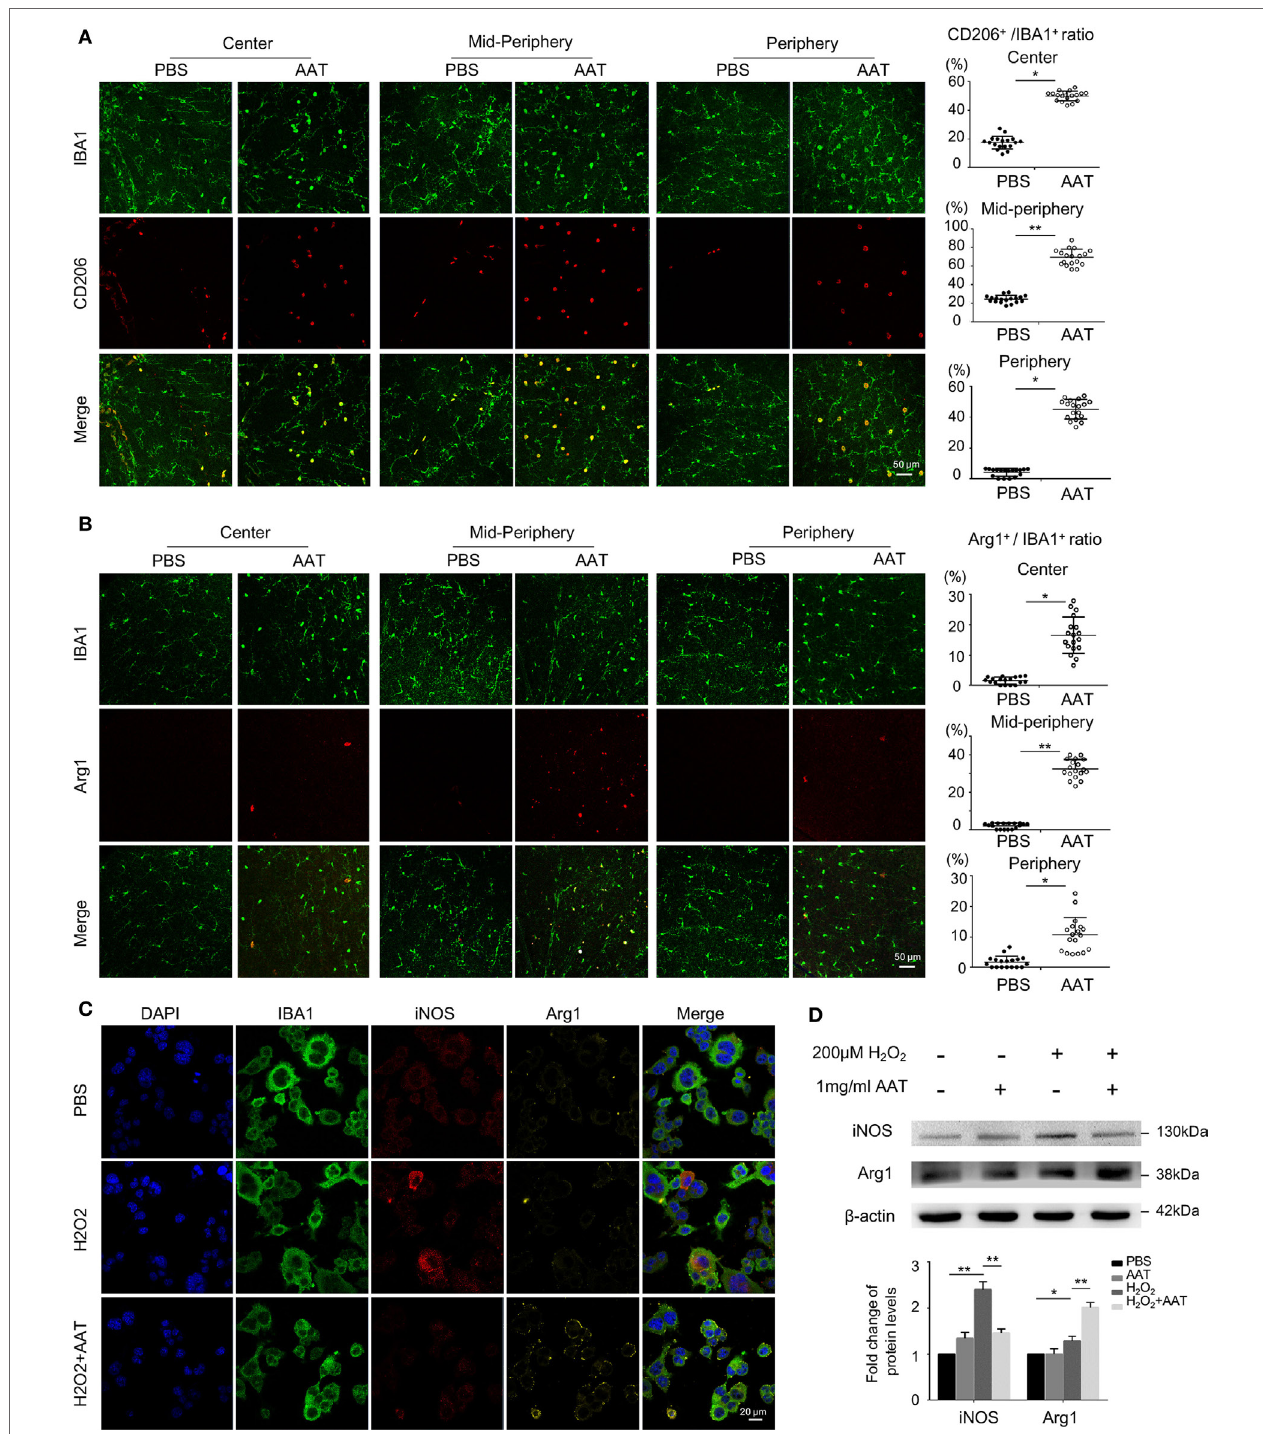
FigUre 7 | Microglia skewed toward anti-inflammatory M2 phenotype in the presence of alpha-1 antitrypsin (AAT) supplement. (a) In the retinal whole mounts, the amount of CD206 + IBA1 + microglia significantly increased in AAT-treated group compared with the PBS-treated mice, particularly in the central and mid-peripheral retina. (B) Arg1 + cells, another M2 microglia marker, were absent in the PBS-treated rd1 retina, while after AAT supplement, these M2 microglia appeared and most concentrated in the mid-peripheral areas. Scare bar, 50 µm. Depicted is mean ± SEM of three fields/eyes from six eyes. * p < 0.05, ** p < 0.01 (two-tailed unpaired t -test). (c) Immunostaining results showed that iNOS was elevated after hydrogen peroxide stimulation on cultured BV2 microglia, in particular expressed in the cytoplasm. In the AAT-treated microglia, not only the expression of iNOS significantly decreased, but also apparent upregulation of Arg1 expression was observed. Scare bar, 20 µm. (D) Western blot revealed that AAT downregulated the expression of iNOS while upregulated the Arg1 expression, the counteracting factor of